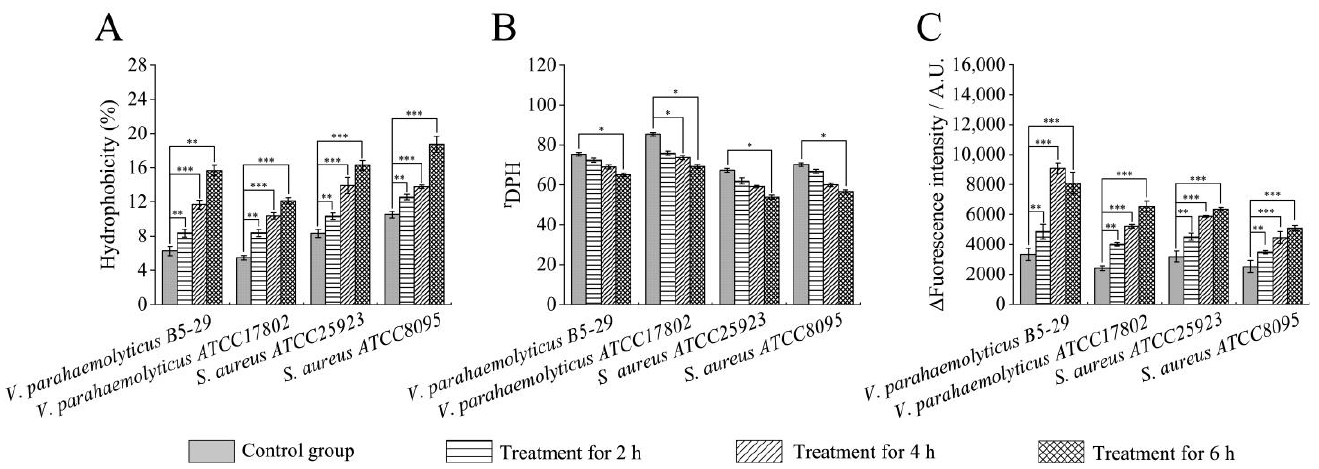
Figure 2. Effects of Fragment 1 (1 × MIC) from P. kleiniana Wight et Arn on cell surface hydrophobicity, membrane fluidity and outer membrane permeability of the four bacterial strains. (A–C) cell surface hydrophobicity, membrane fluidity, and outer membrane permeability, respectively. *: p < 0.05; **: p < 0.01; and ***: p < 0.001.